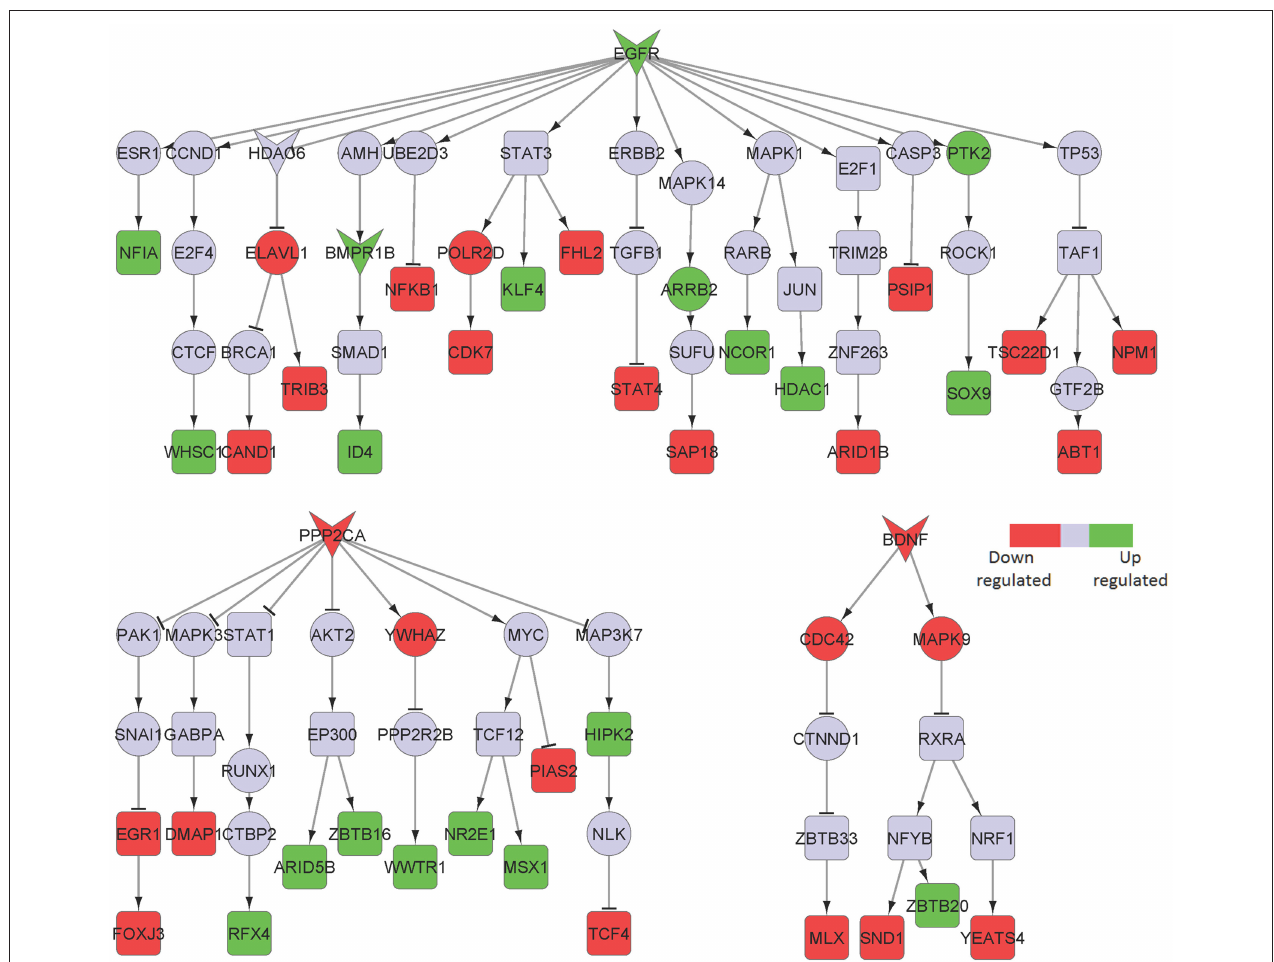
FIGURE 7 | Key signaling networks identified for the superior frontal gyrus. The figure shows three signaling subnetworks controlled by EGFR, PPP2CA, and BDNF for the superior frontal gyrus with known role in AD. EGFR signaling subnetwork was found to be constantly activated and controlled 7 up- and 11 downregulated TFs. PPP2CA and BDNF were found to be constantly inhibited signaling subnetworks. PPP2CA was found to regulate 7 up- and 5 downregulated TFs, while BDNF was found to regulate 1 up- and 3 downregulated TFs. The figure legends are the same as that in Figure 2